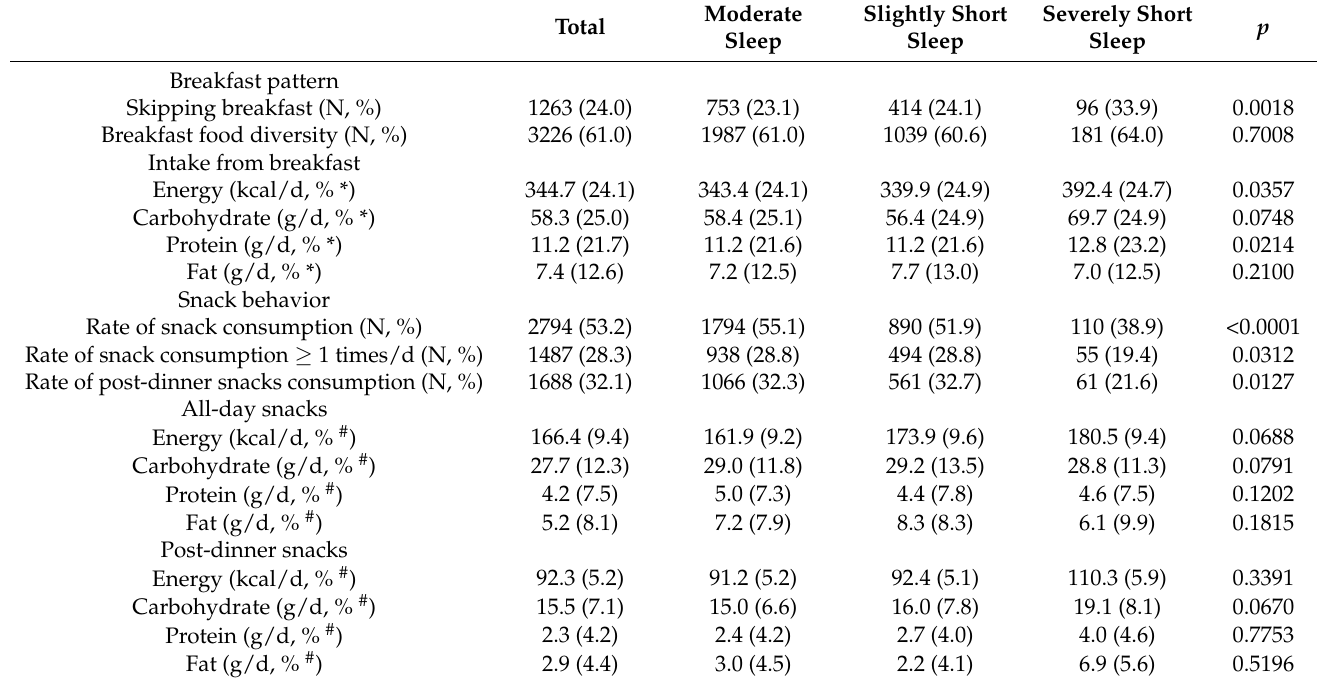
Table 2. Breakfast patterns of children with different sleep duration.